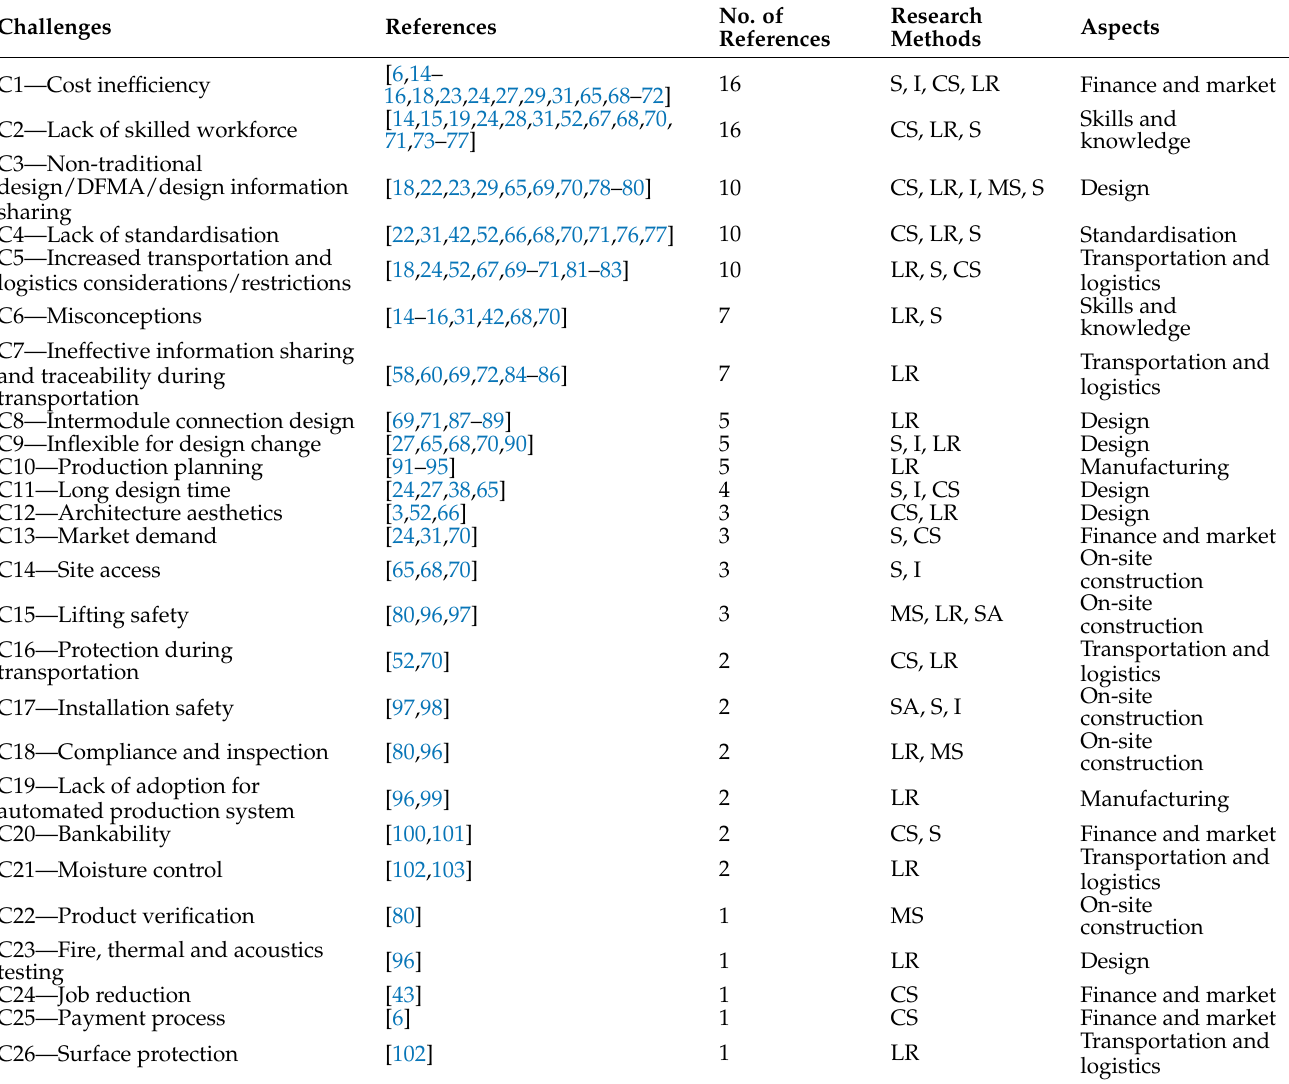
Table 3. Summary of previous research on the challenges of